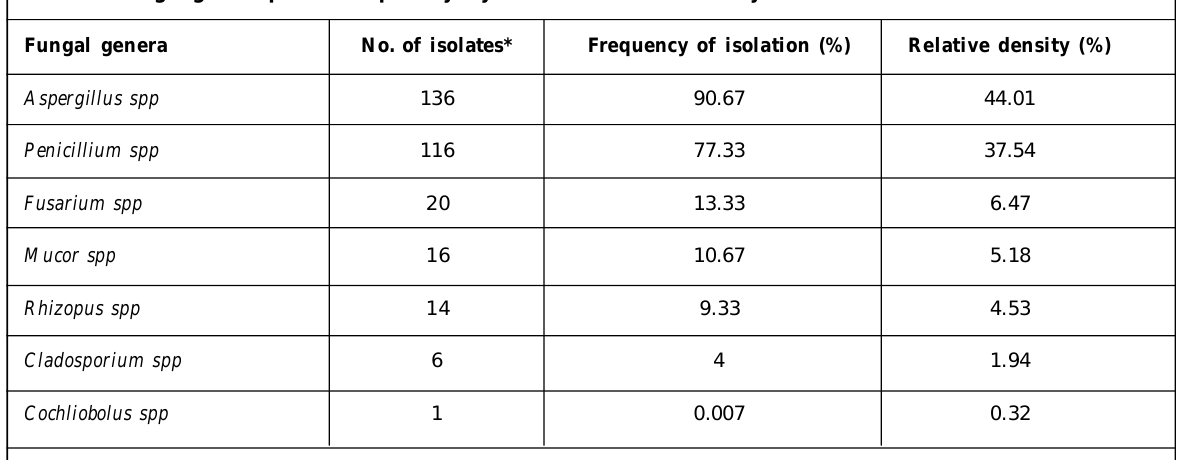
Table 1: Fungal genera present in poultry layer feed in Nairobi County Fungal genera No. of isolates* Frequency of isolation (%) Relative density (%) Aspergillus spp 136 90.67 44.01 Penicillium spp 116 77.33 37.54 Fusarium spp 20 13.33 6.47 Mucor spp 16 10.67 5.18 Rhizopus spp 14 9.33 4.53 Cladosporium spp 6 4 1.94 Cochliobolus spp 1 0.007